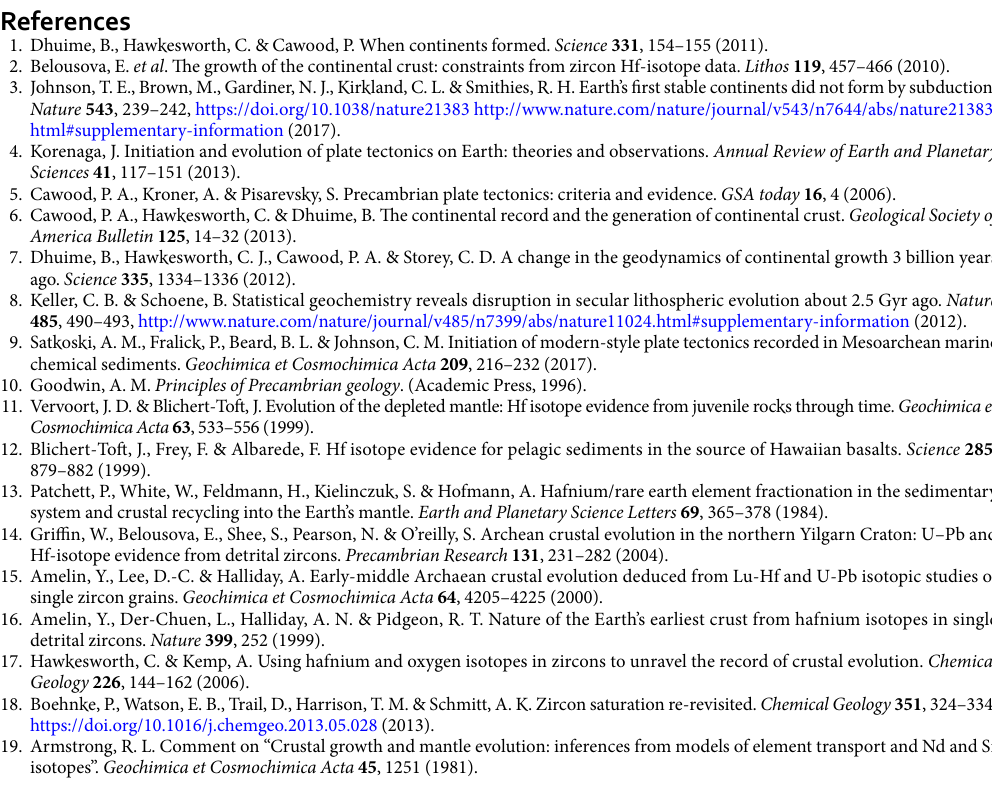
accompanied by the first records of subaerial large igneous provinces 38 and deviations in 87 Sr/ 86 Sr isotope ratios in seawater away from background mantle values after 3 Ga 39 , and evidence for a global increase in the sedimentary contribution to the magmatic record through higher δ 18 O since the late Archean 40 . These observations suggest that significant volumes of continental crust had emerged 41–45 and were available for surficial weathering. Our data on the Hf isotopic composition of black shales from the Pilbara craton indicate a change from the formation of juvenile crust to more evolved crustal sources and associated intra-crustal reworking from that time onwards. The timing of this change is proposed to initiated at around 3.2 Ga based on the peak in Hf model ages of the < 3 Ga old shale data. Our approach using ‘zircon-free dissolutions’ of black shales provide evidence from a crustal source without any influence of biased material, such as for instance zircons with a low Lu/Hf. We therefore are able to provide information on pristine crustal material within the limitations of the sampling area. In combination with other global data sets, we consider this change from formation of juvenile crust to crustal reworking to reflect the sub- aerial emergence of significant volumes of continental crust in the Pilbara region. This change in the character of the Pilbara crust is consistent with a change in global geodynamics from a stagnant lid to a plate tectonic regime e.g., 6,31,33,46 and took place in response to increasing lithospheric rigidity through mantle cooling.